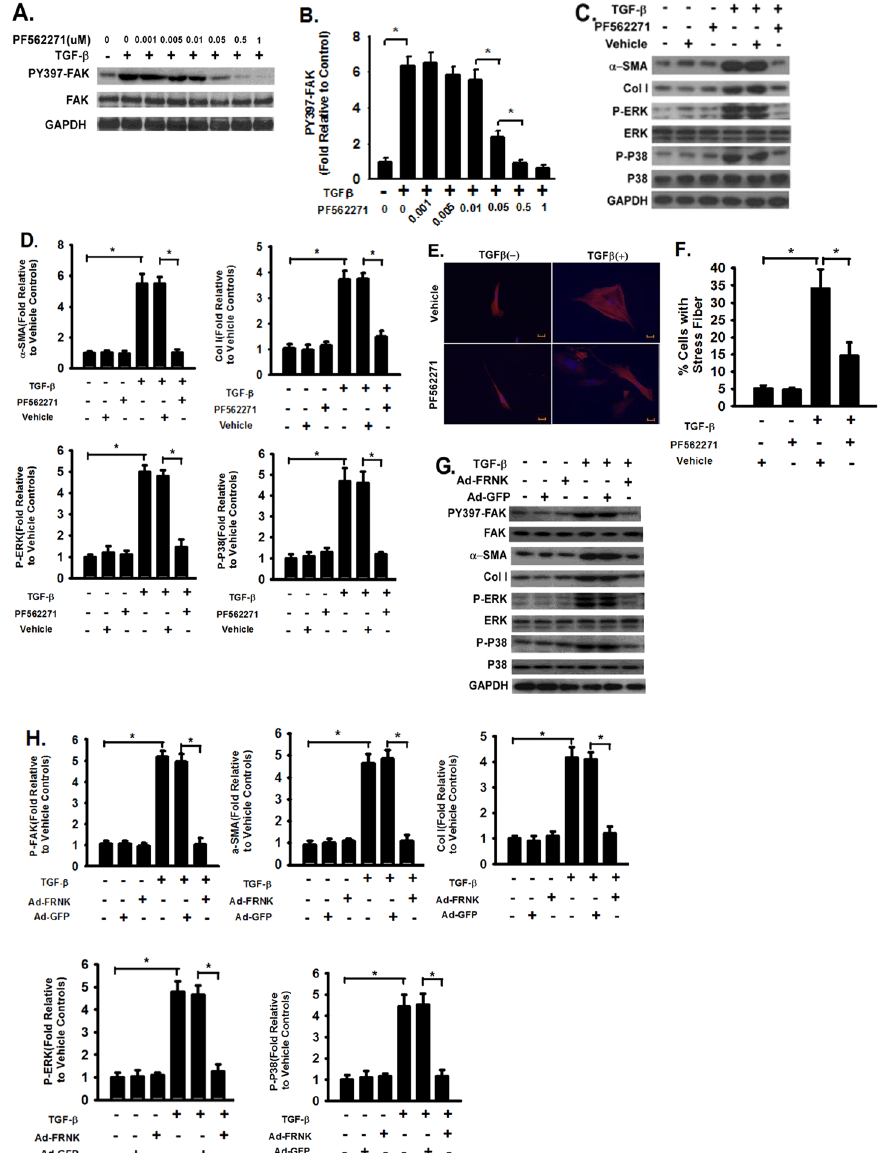
Figure 3. Pharmacologic inhibition of FAK activation inhibits HSC activation, myofibroblast differentiation, and collagen expression. ( A ) Serum starved (for 20 hours) primary mouse HSCs were treated with TGF- β 1 (2 ng/ml) followed by FAK inhibitor (PF562271) at the indicated dose or vehicle for 24 hours, and lysed. Equivalent amount of whole cell detergent lysates were western blotted with the indicated antibodies. ( B ) Densitometry analysis of the effect of FAK inhibitor on phosphorylation of Y397 of FAK (normalized to total FAK) at the indicated dose. ( C ) Serum starved (for 20 hours) primary mouse HSCs were treated with TGF- β 1 (2 ng/ml) followed by FAK inhibitor (PF562271, 0.5 µ M) or vehicle for 24 hours, and lysed. Equivalent amount of whole cell detergent lysates were western blotted with the indicated antibodies. ( D ) Densitometry analysis of the effect of FAK inhibitor on myofibroblast differentiation (by α -SMA expression) and collagen expression (Col 1) (normalized to GAPDH) in panel C. ( E ) HSCs were treated as in panel C, fixed after 24 hours, immunofluorescently stained with Cy-3-labelled monoclonal antibody toward α -SMA (red), and fluorescent microscopic digital images were taken (200X). Nuclear were staining with Hoechst (blue) and right bottom shows a scale bar (15 µ m). Representative pictures were shown. ( F ) Quantification of the percentage of cells with newly formed α -SMA-containing stress filaments. ( G ) Cells were infected with adenoviral vectors containing the dominant negative regulator of FAK, the FAK-related non-kinase (FRNK) or GFP and treated as in panel C. Equivalent amount of whole cell detergent lysates were western blotted with the indicated antibodies. ( H ) Densitometry analysis of the effects of FRNK expression in panel G. Data were pooled from at least three independent experiments and represented as mean ± SE. * p represents <